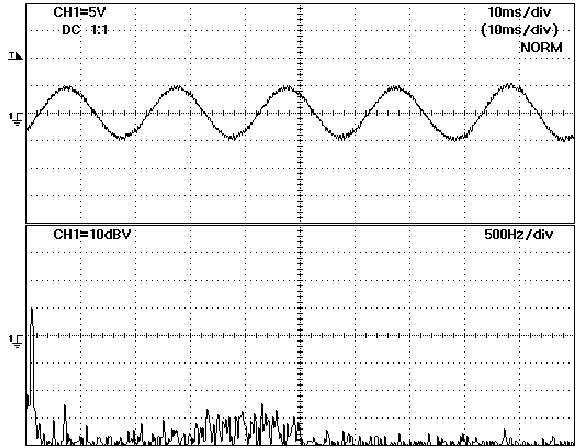
Figure 10. Power spectral density of line current (iB) 10 dBV/div.